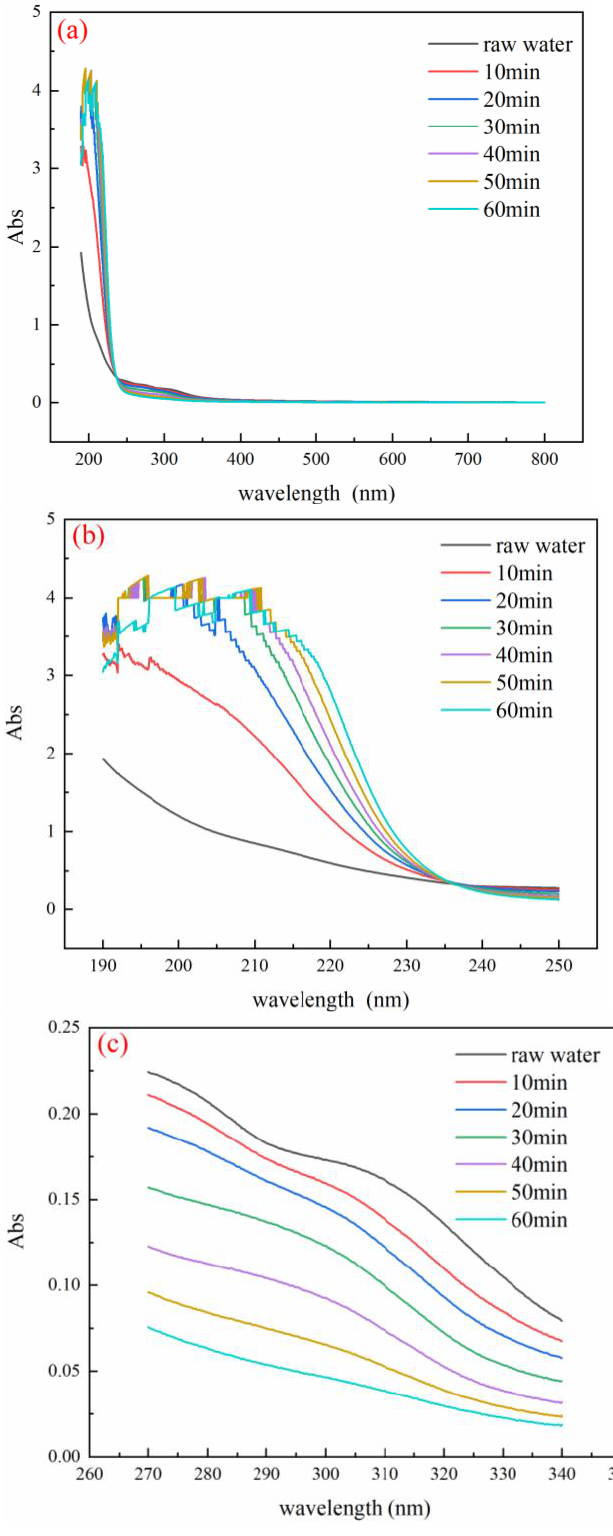
Figure 5. UV – visible spectrum of coal chemical wastewater: ( a ) 190 – 800 nm; ( b ) 190 – 250 nm; ( c ) 270 – Figure 5. UV–visible spectrum of coal chemical wastewater: ( a ) 190–800 nm; ( b ) 190–250 nm; 340 nm. ( c ) 270–340